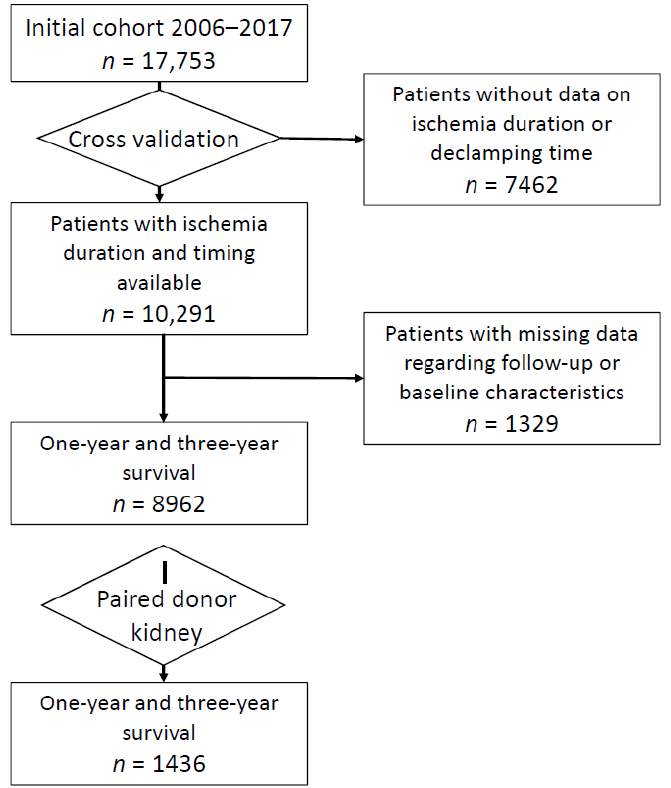
Figure 1. Flow chart of the study population.